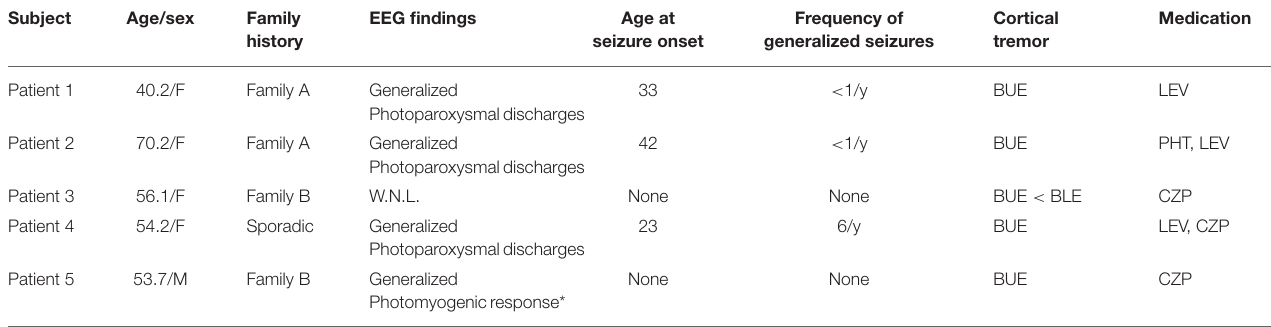
TABLE 1 | Patient demographic